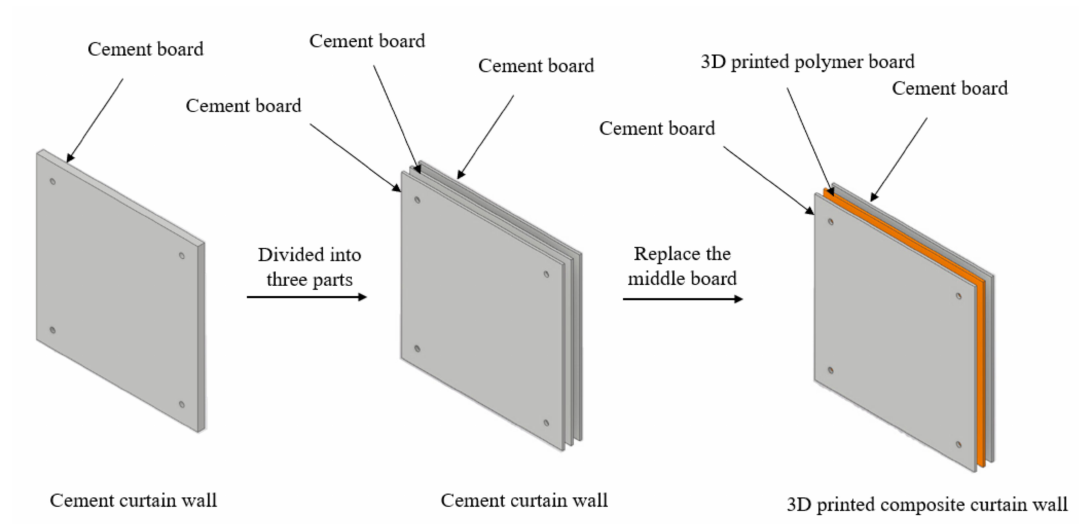
Figure 3. Concept of the 3D printed composite curtain wall (3DP CCW).